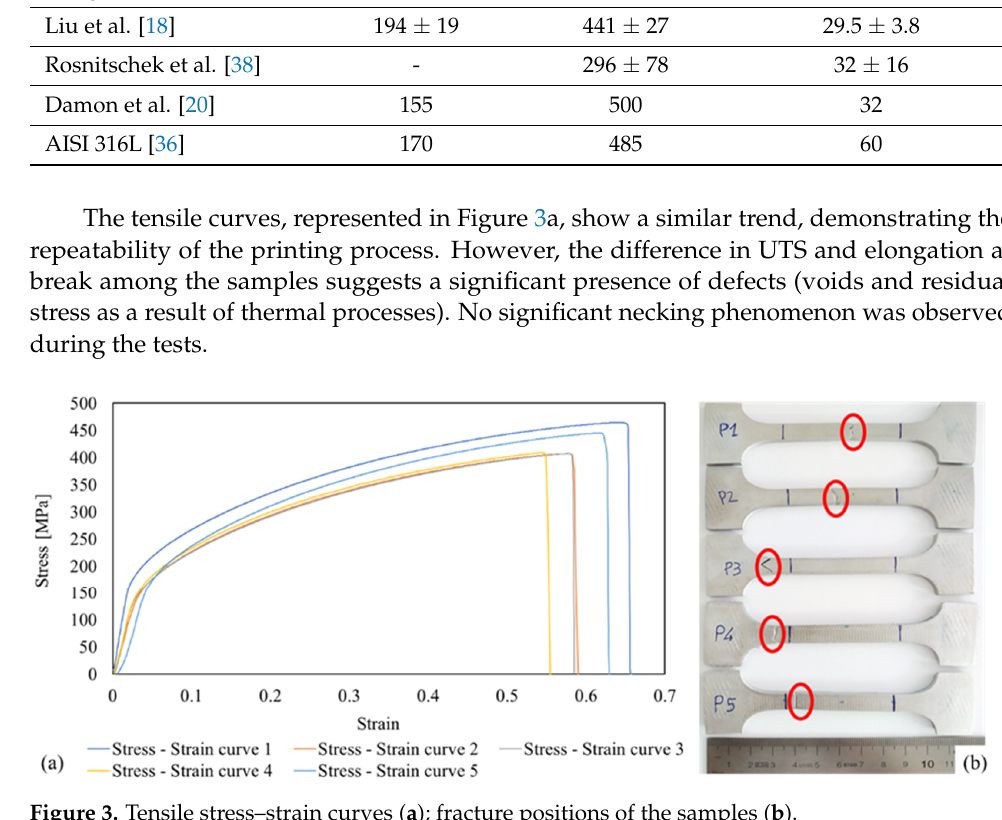
tures inside the useful length, indicated by two blue lines near the edge of the samples. In contrast, samples 3 and 4 show fractures near the filet radius, which is a critical stress intensity zone.